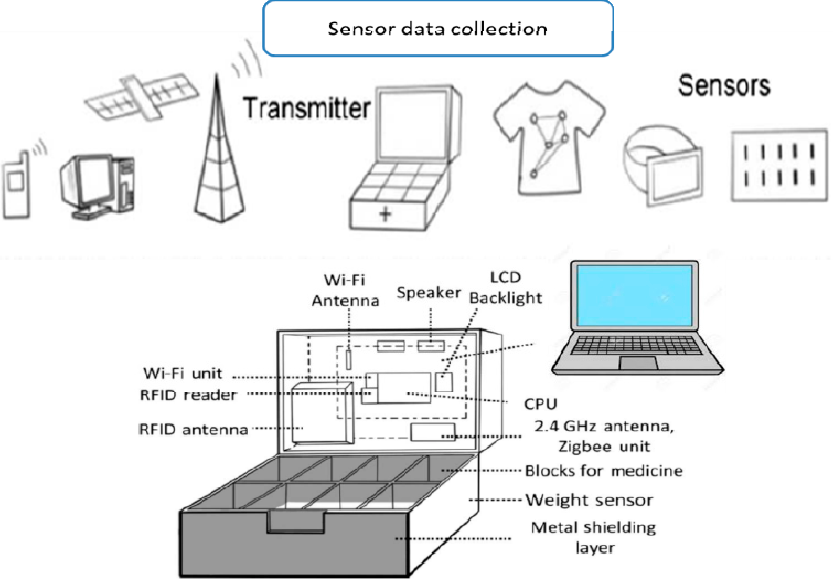
Figure 5. Architectural design of the iMedBox.